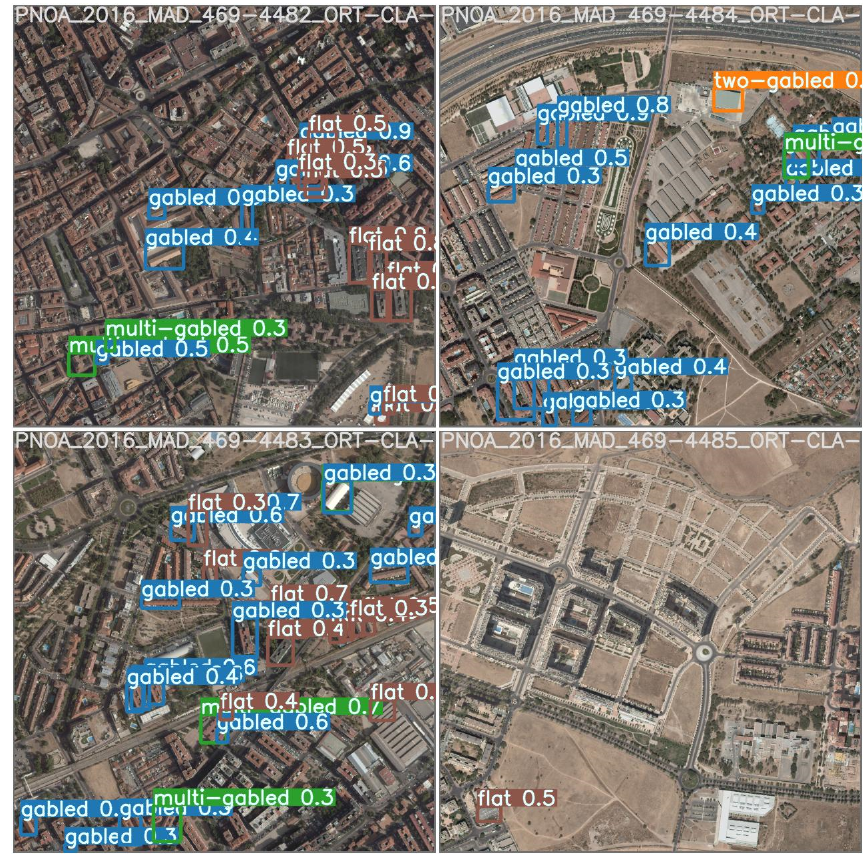
Figure 8. Bounding boxes of Alcalá de Henares imposed by the trained neural network